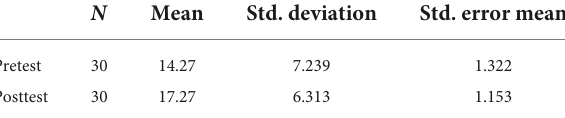
TABLE 2 One-sample